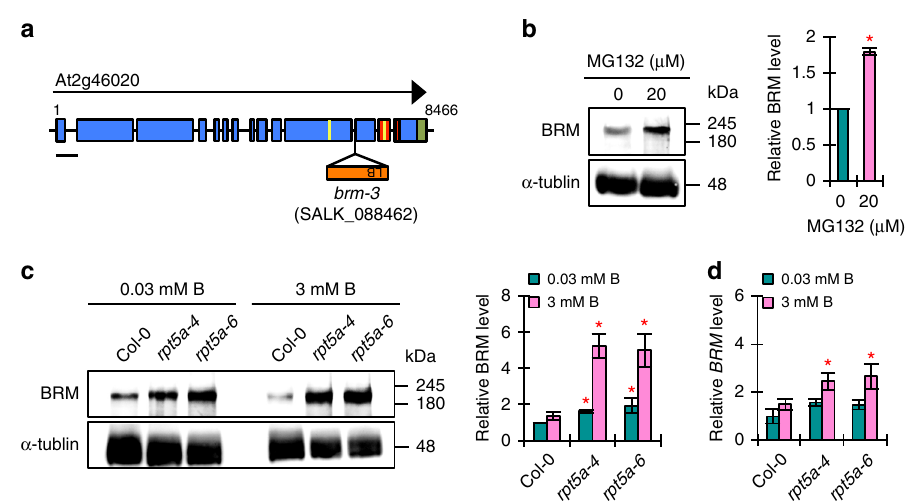
Fig. 6 A 26SP containing RPT5a regulates BRM levels in roots. a Gene structure of BRM . Blue and green boxes indicate coding regions and untranslated regions, respectively. Red and yellow bars indicate regions encoding PEST motifs and KEN-boxes, respectively. Scale bar, 500 bp. b Effect of MG132 treatment on BRM accumulation in Col-0 roots. The right panel shows the relative level of BRM accumulation normalized against α -tubulin ( n = 3, average ± s.e.m.; P < 0.05, Student ’ s t -test). c BRM levels in the roots of Col-0 and rpt5a mutant plants grown under normal- and high-B conditions. The right panel shows the relative level of BRM accumulation normalized against α -tubulin ( n = 3, average ± s.e.m.; P < 0.05, compared with Col-0 under 0.03 mM B conditions, Student ’ s t -test). d BRM mRNA levels in the root tips of Col-0 and rpt5a mutant plants grown under normal- and high-B conditions ( n = 4, average ± s.e.m.; P < 0.05, compared with Col-0 under 0.03 mM B conditions, Student ’ s t